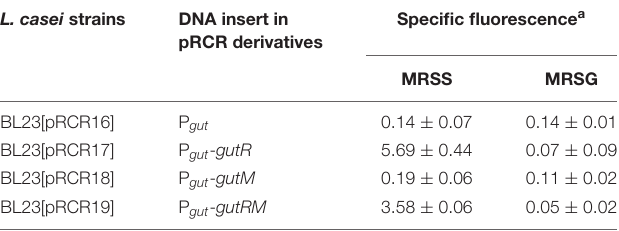
TABLE 3 | Heterologous expression of components of the P. parvulus 2.6 gut operon in L. casei BL23 carrying pRCR derivatives plasmids grown in either MRSS or